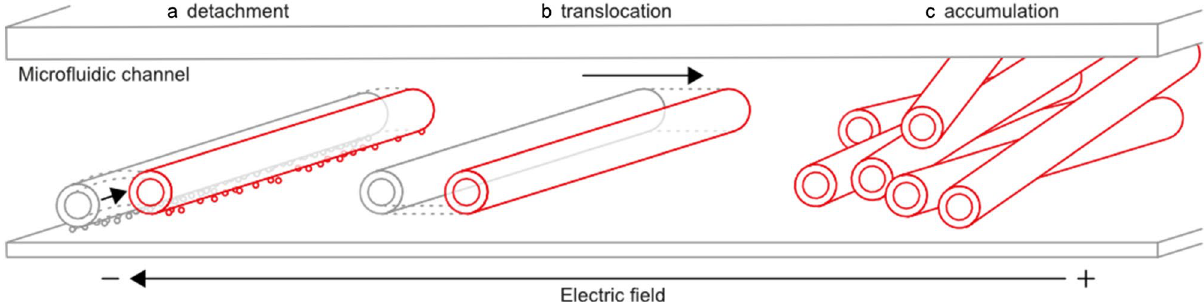
Figure 5. The scheme describing the on-chip effects of µ s-PEF on microtubules. (a) µ s-PEF detaches microtubules from the substrate—this effects requires high electric field strength, which would be unattainable in DC regime. (b) µ s-PEF translocates the microtubules by electrophoretic force towards the anode. (c) µ s-PEF accumulates microtubules at the area where the electric field strengths drops below a threshold level capable of detaching and translocating presented in Fig. 4e. As shown in the graph, the value of the MT displacement index speed was proportional to the applied pulse voltage. This finding is understandable, because the electric field is expected to act on MTs by a force, which is linearly proportional to the applied pulse voltage. However, substantial displacement of MTs starts to appear only from the threshold voltage of 210 V onwards. How can this threshold effect be explained? We propose that the most likely mechanism is that the electric field needs to overcome the antibody-mediated binding of MTs to the substrate. To detach any of the MTs, the electric field has to be higher than a certain threshold. The specific threshold value will likely depend on how many antibodies are holding the MTs at the surface (as a support of this concept, see atomic force microscopy analysis of ferritin-antiferritin antibody bond breaking force 34 ), per MT length, which is statistically determined by the antibody surface density. We can see that substantial effects are seen from the applied voltage of approximately 210 V and up. From the applied voltage, we can also estimate the field strength, force, and estimated anti-body density; see “Forces underlying microtubule detachment” for the detailed quantitative discussion. Another effect that we observed, as a consequence of the MT displacement, was the increasing overlap and concentration (accumulation) of MTs with increasing voltage (Fig. 3j). We propose the following mechanism behind this effect: when an electric field "sweeps" MTs to the region where the field is already not strong enough, further displacement of MTs is not possible anymore. The concentration of MTs in that region increases and they accumulate and overlap. Although MTs have a negative charge and are expected to repel each other, they are also surrounded by a counterion cloud that screens the mutual repulsion between MTs (calculated Debye length is approximately 0.7 nm for our experimental conditions, see supplementary material S1 and S8). A crowding agent, methyl cellulose, was used in our experiments to keep MTs at the imaging plane. If no methyl cellulose was present, MTs were not only detached from the surface by µ s-PEF but they were also removed from the image plane and disappeared from the field of view (see supplementary videos S6 and S7). Methyl cellulose, as other crowding agents, might also contribute to MT clumping and bundle formation in vitro 35,36 owing to the depletion